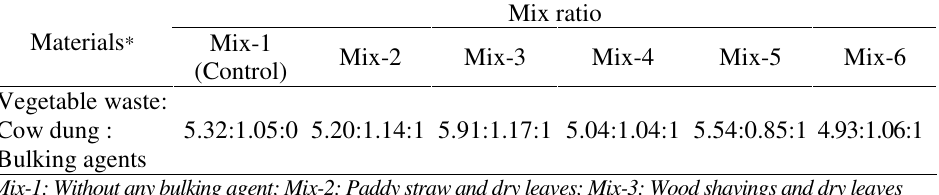
Table 1. Bulking agents in different mix